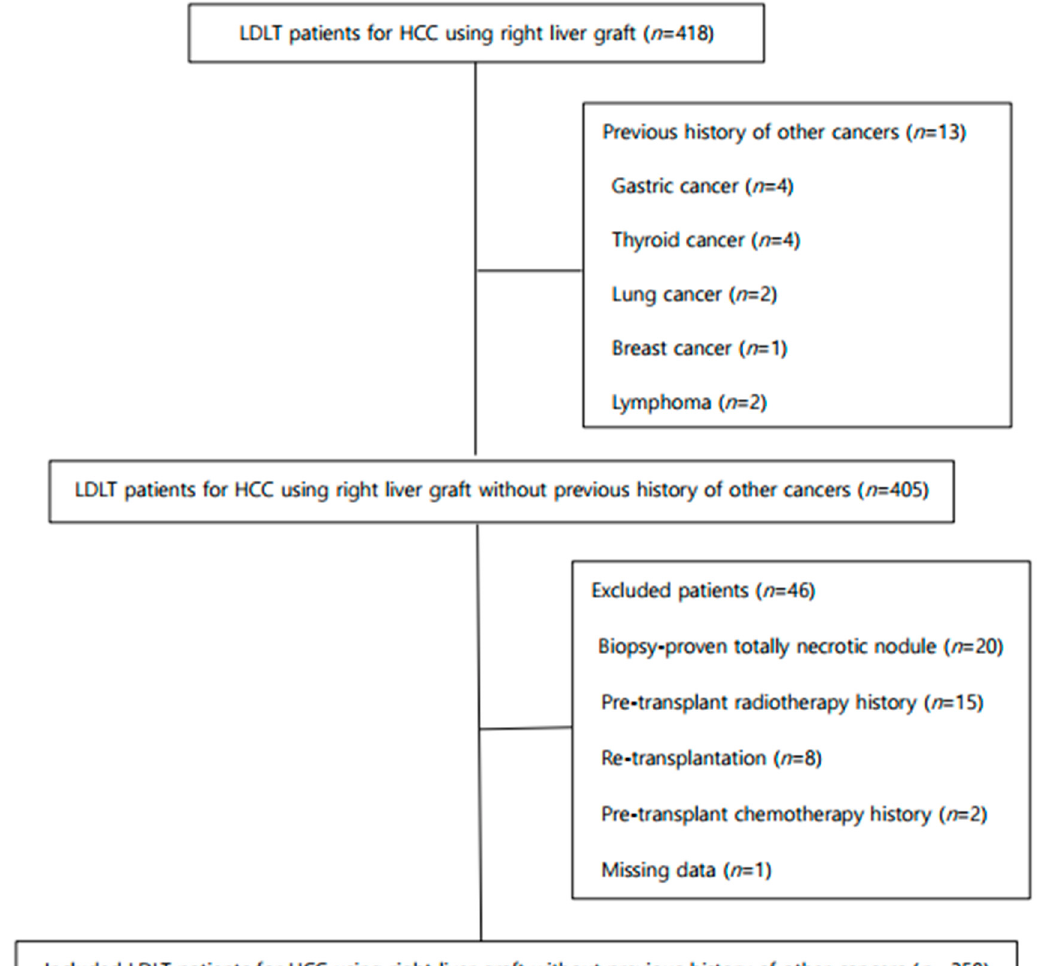
Figure 1. Study flowchart. Patients undergoing LDLT for HCC without the history of other cancers. HCC, hepatocellular carcinoma; LDLT, living-donor liver transplantation .